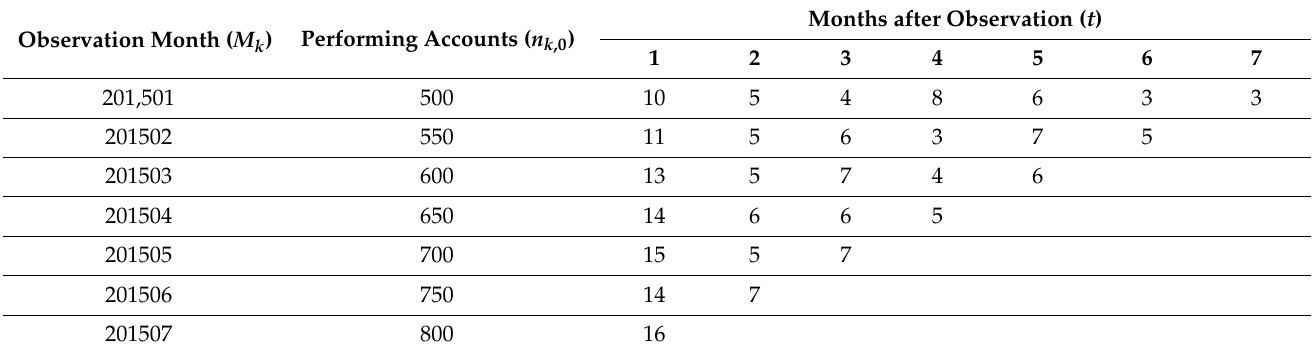
Table 1. Example of the defaults